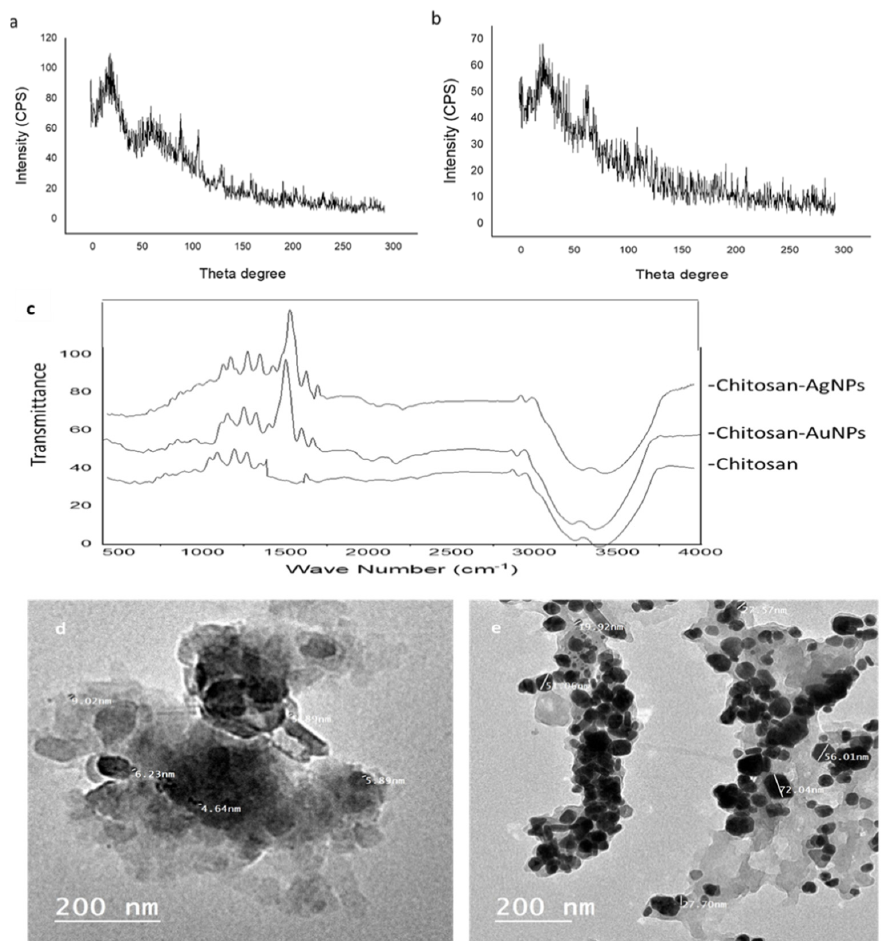
Figure 4. XRD of ( a ) chitosan-AgNPs, ( b ) chitosan-AuNPs, and ( c ) FTIR of chitosan, chitosan–AgNPs and chitosan–AuNPs; ( d , e ) TEM micrographs of chitosan–AgNPs and chitosan–AuNPs, respectively.